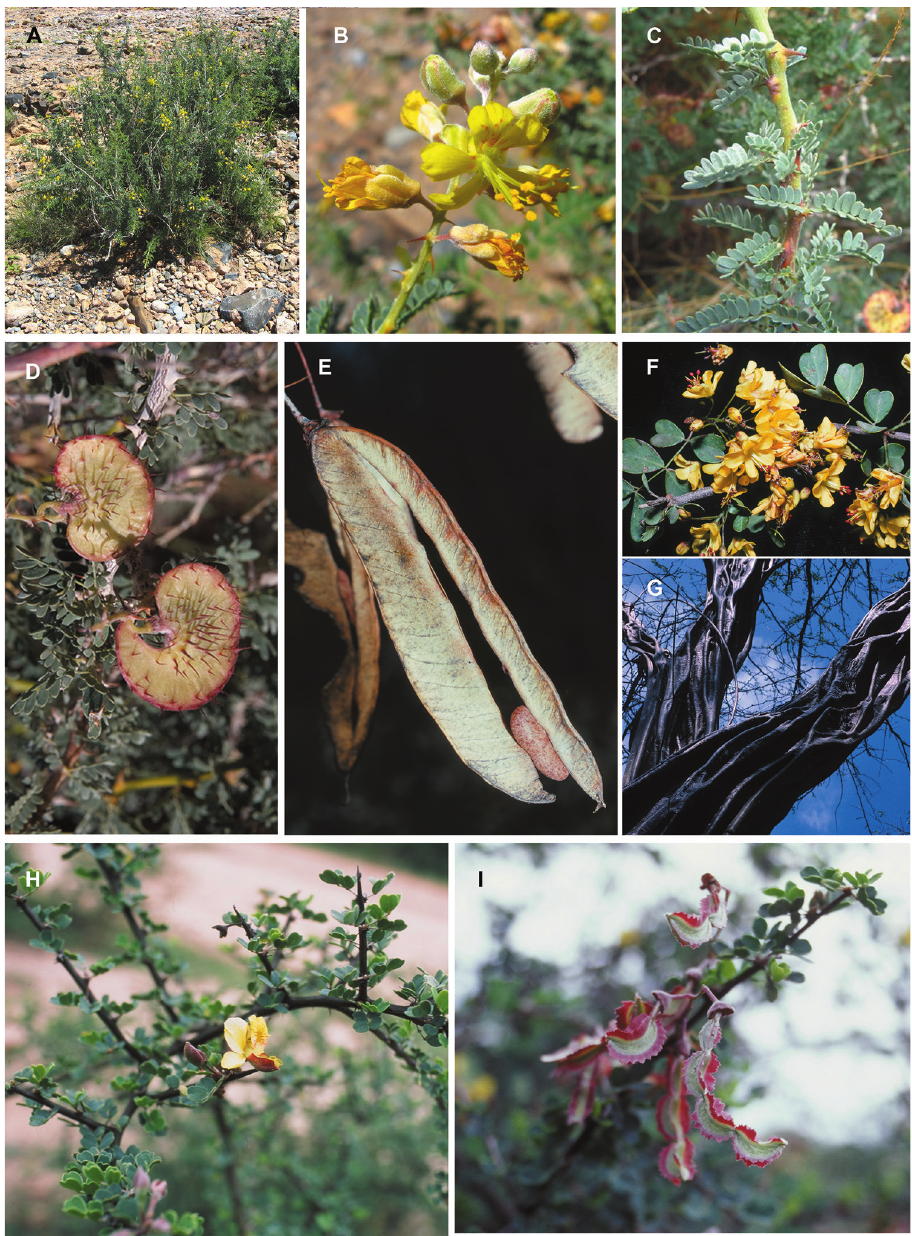
Figure 5. Hererolandia pearsonii (L. Bolus) E. Gagnon & G. P. Lewis. A shrubby habit B inflorescence C branch showing prickles and leaves D fruits (A. A. Dreyer, Sesriem Canyon, Namibia, unvouchered ). Hae- matoxylum brasiletto H. Karst. E mature fruit dehiscing along the mid-valve (C. E. Hughes, Mexico, un- vouchered ) F inflorescences and leaves (G. P. Lewis, Mexico, Lewis 2057 (K)) G distinctively fluted trunks (C. E. Hughes, Oaxaca, Mexico, Hughes 1947 (FHO)) Lophocarpinia aculeatifolia (Burkart) Burkart H shrub with flowers, armed with straight conical spines I fruits (R. H. Fortunato, Paraguay, Fortunato 8650